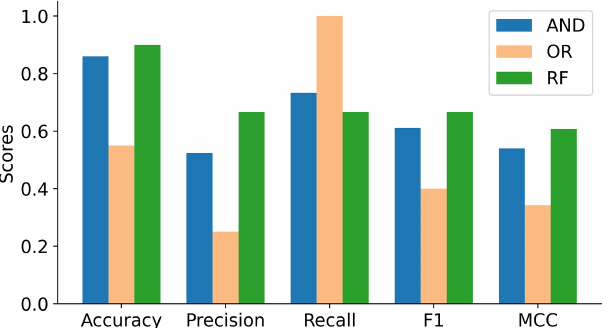
Figure C7. Evaluation of each approach in identifying crop failures for the observed data under different performance categories: accuracy, precision, recall, F1 and MCC. The approaches are AND (blue), OR (orange) and RF (green).